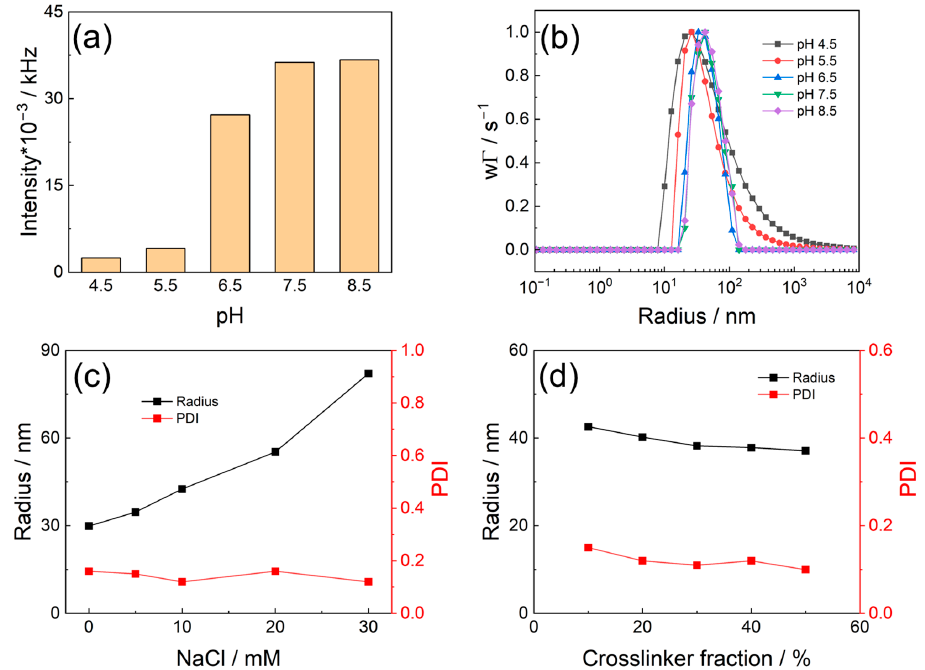
Figure 2. ( a ) Light sca tt ering intensity of particles after UV light irradiation for 3 h prepared at dif- ferent pH. ( b ) Size distribution of PMETAC nanogel prepared at di ff erent pH after removing tem- plate. Hydrodynamic radius and polymer dispersity index (PDI) of PMETAC nanogel prepared at di ff erent added sodium chloride concentration ( c ) and crosslinker fraction ( d ). Nanogel synthesis was carried out at charge mixing ratio 1:1, cross-linker fraction 10% and with di ff erent pH or sodium